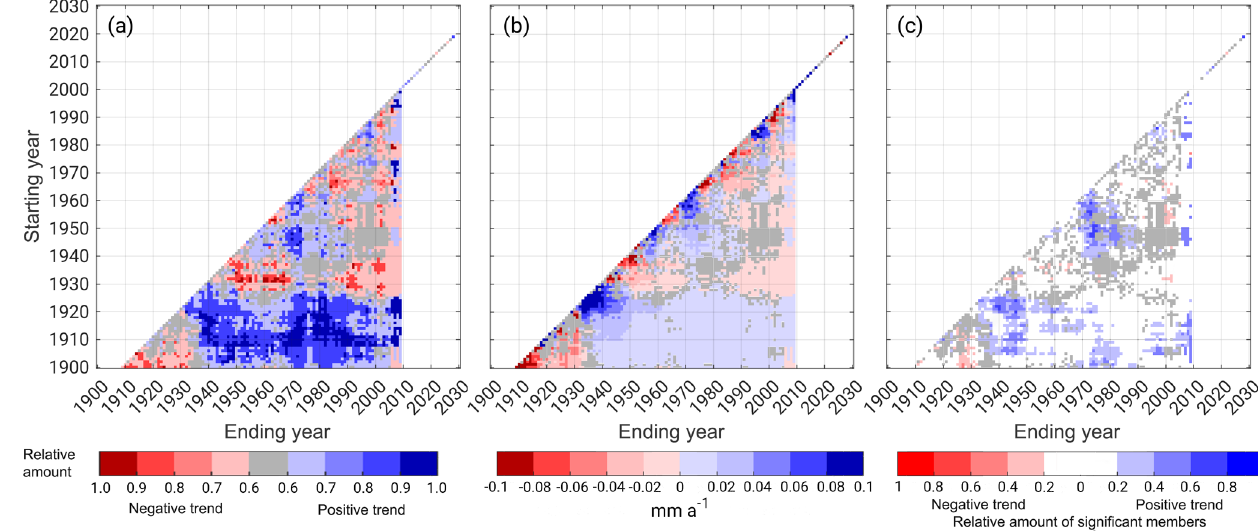
Figure 9. Trend analysis of the 99th percentile (wet days only) of daily spatial mean precipitation for ME with (a) the relative amount of members of LAERTES-EU with a positive (blue) or negative (red) trend; (b) the trend in millimeters per year averaged over the members from panel (a) , and (c) relative amount of members from panel (a) with a significant trend; cases with no distinct number (less than 60%) of members with same trend sign are marked in gray in panels (a) – (c)